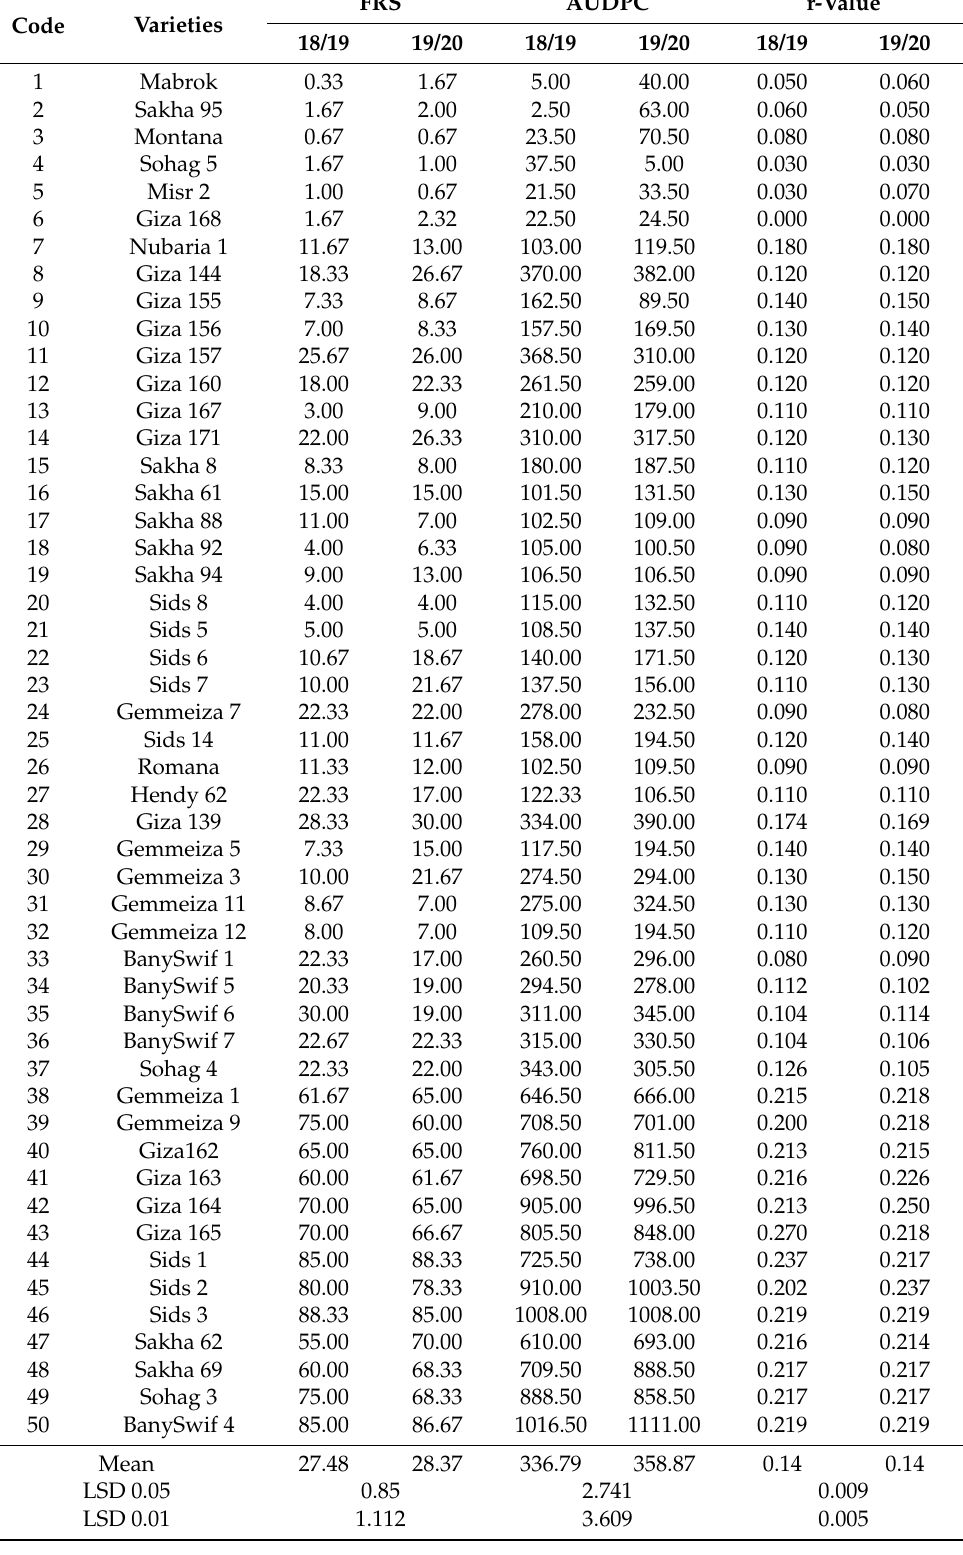
Table 1. Final leaf rust severity (%), area under disease progress curve (AUDPC) and rate of leaf rust disease increase (r-value) in Sids location during 2018/19 and 2019/20 growing